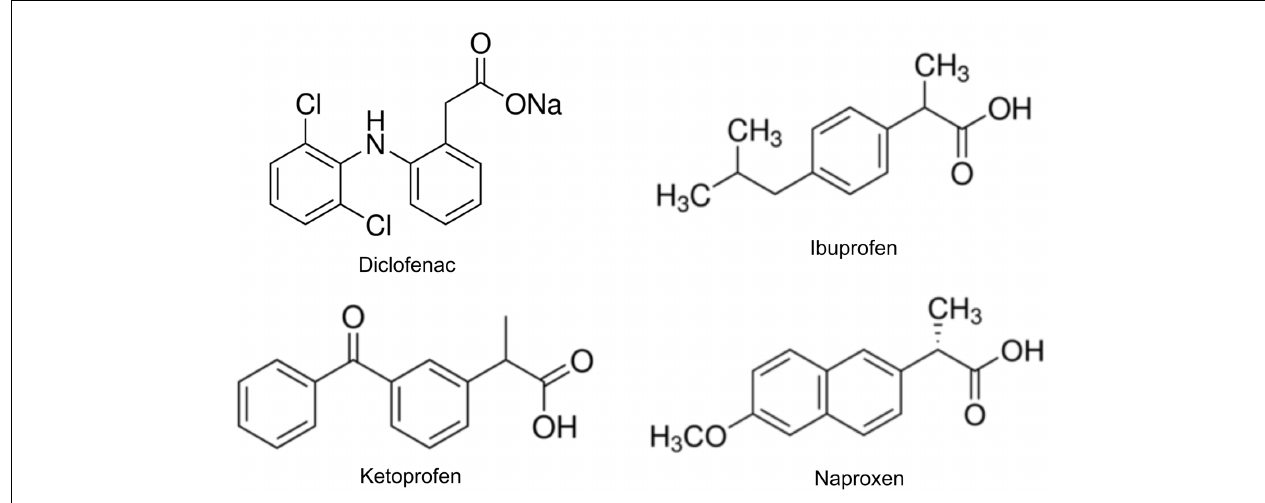
FIGURE 1 | Chemical structure of the selected non-steroidal anti-inflammatory drugs (NSAIDs).